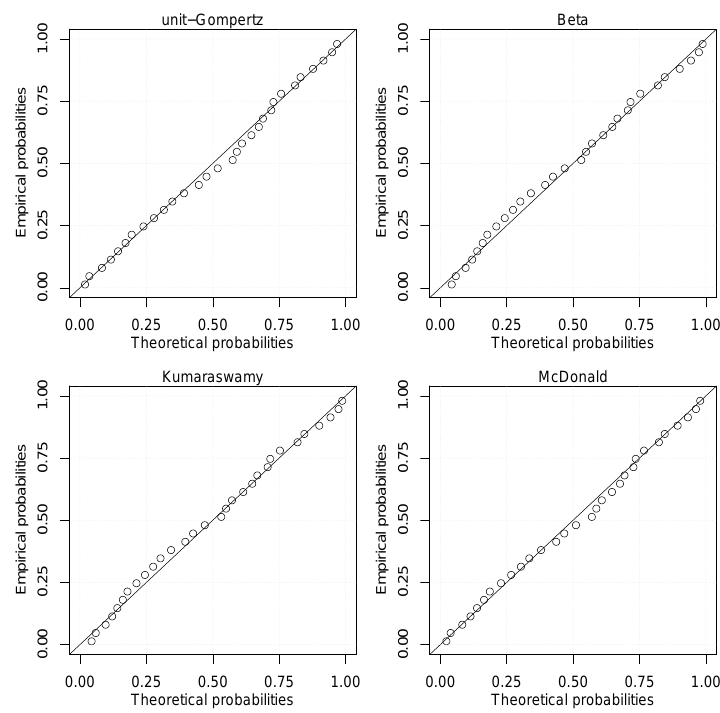
Figure 5 – PP-Plots of the fitted distributions — Data Set